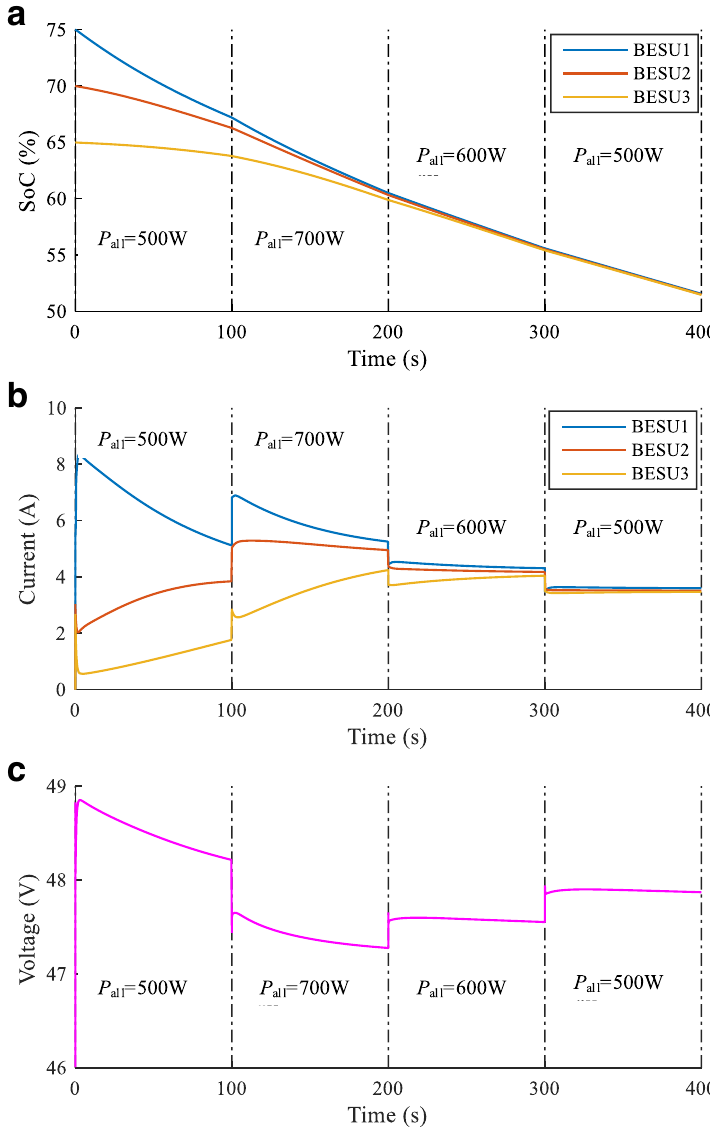
Fig. 7 Simulation results in discharging